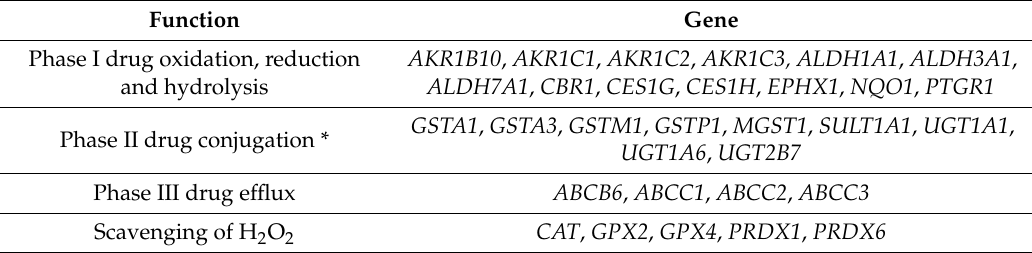
Table 1. NRF2-target